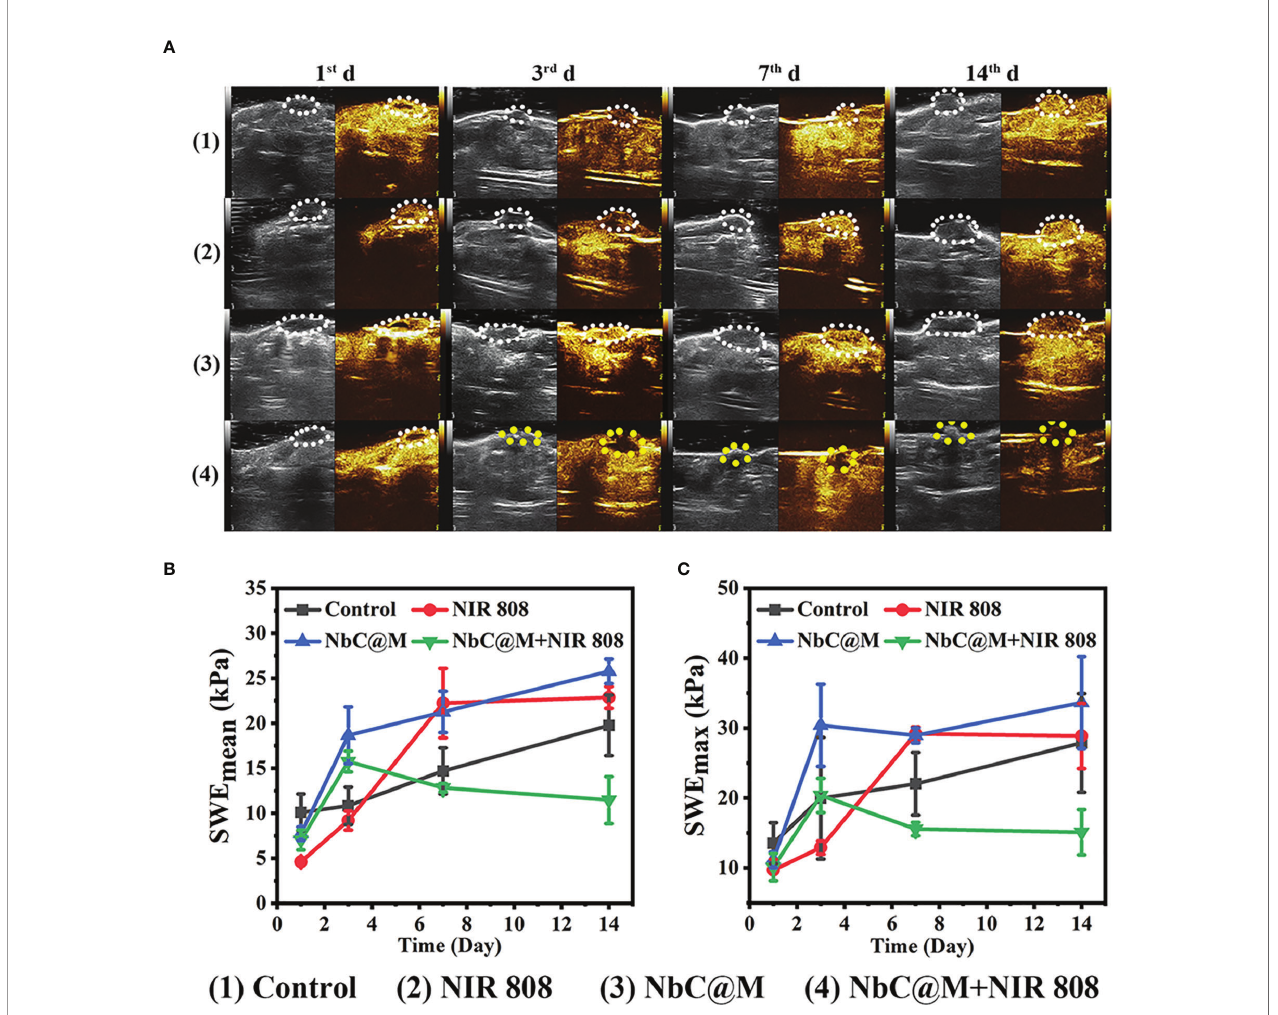
FIGURE 6 | Contrast-enhanced ultrasound (CEUS) and shave wave elastography (SWE) observation on HepG2 tumor-bearing mice after different treatments. (A) CEUS detection of tumor internal changes during 14 days post treatment. The changing trend in terms of mean (B) and maximum (C) values of the SWE at the tumor site during 14 days post